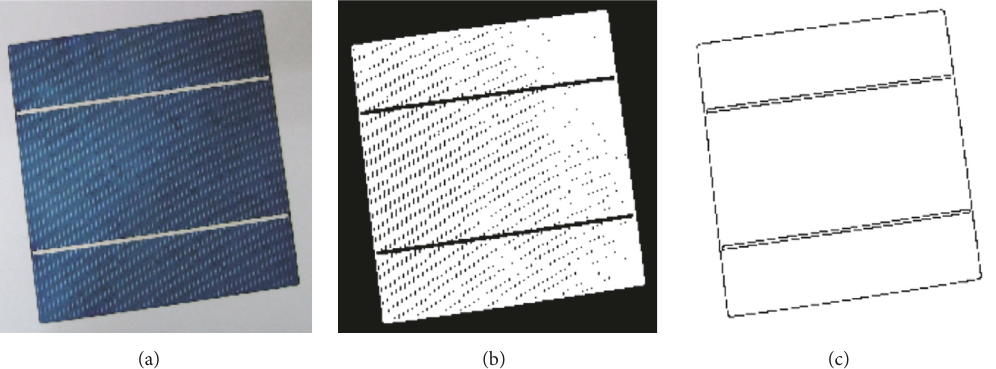
Figure 5: Gray background solder panel image processing: (a) original image; (b) HPD thresholding; (c) initial edge extracted by fractional Gaussian template.